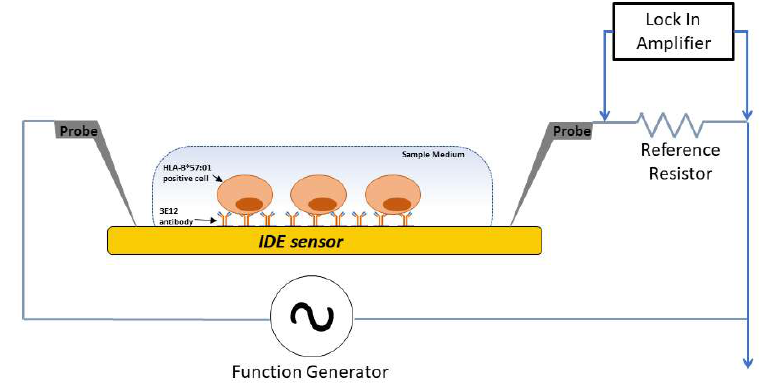
Figure 1. Circuit model and measurement setup used for detection of HLA-B*57:01 cell capture.